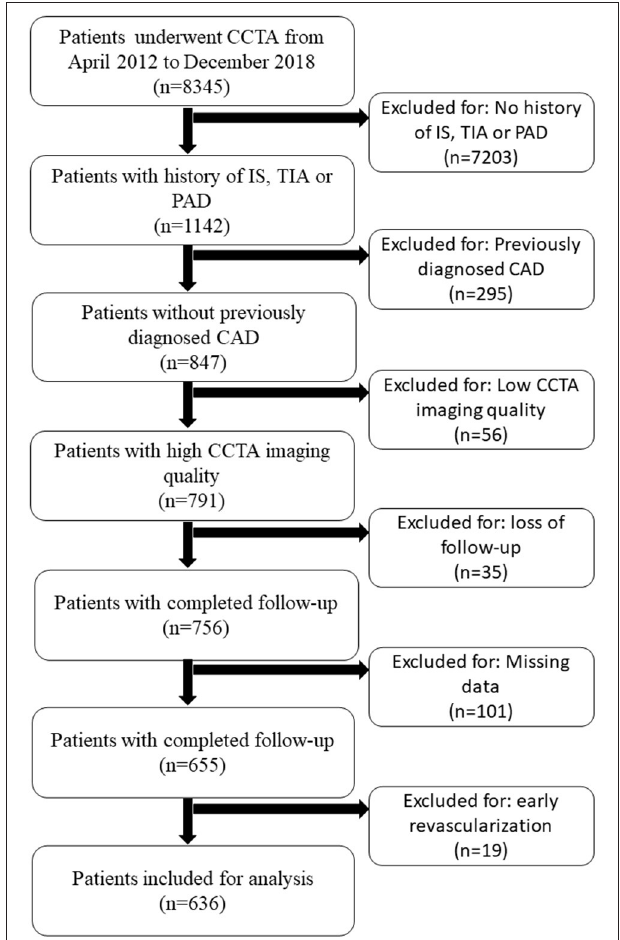
FIGURE 2 | Patient selection flow chart. CAD, coronary artery disease; CCTA, coronary computed tomography; IS, ischemic stroke; PAD, peripheral artery disease; TIA, transient ischemic